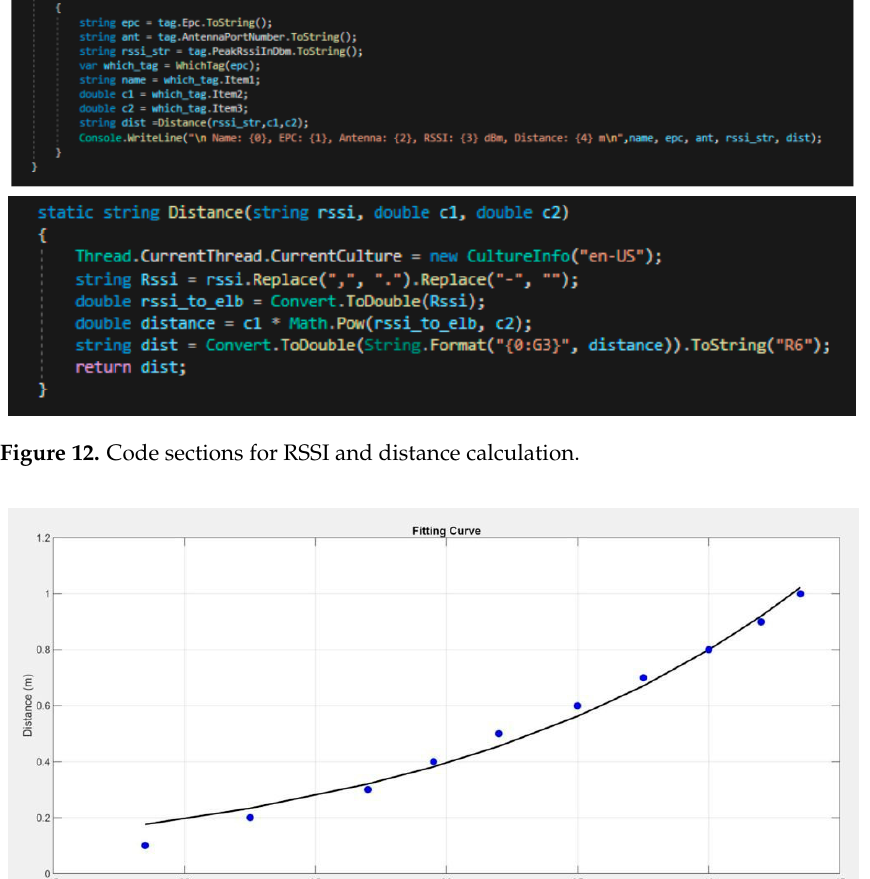
Figure 13. Example: Distance versus RSSI (absolute values in dBm). Measurements (dots) and fitting line (solid line).